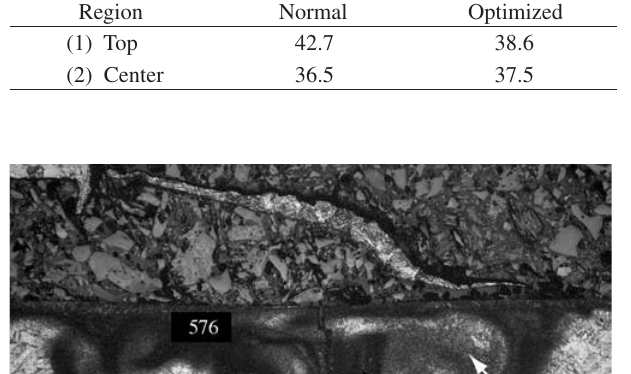
Table 2. Nitrogen content analyses in welds (molar percentage). Region Normal